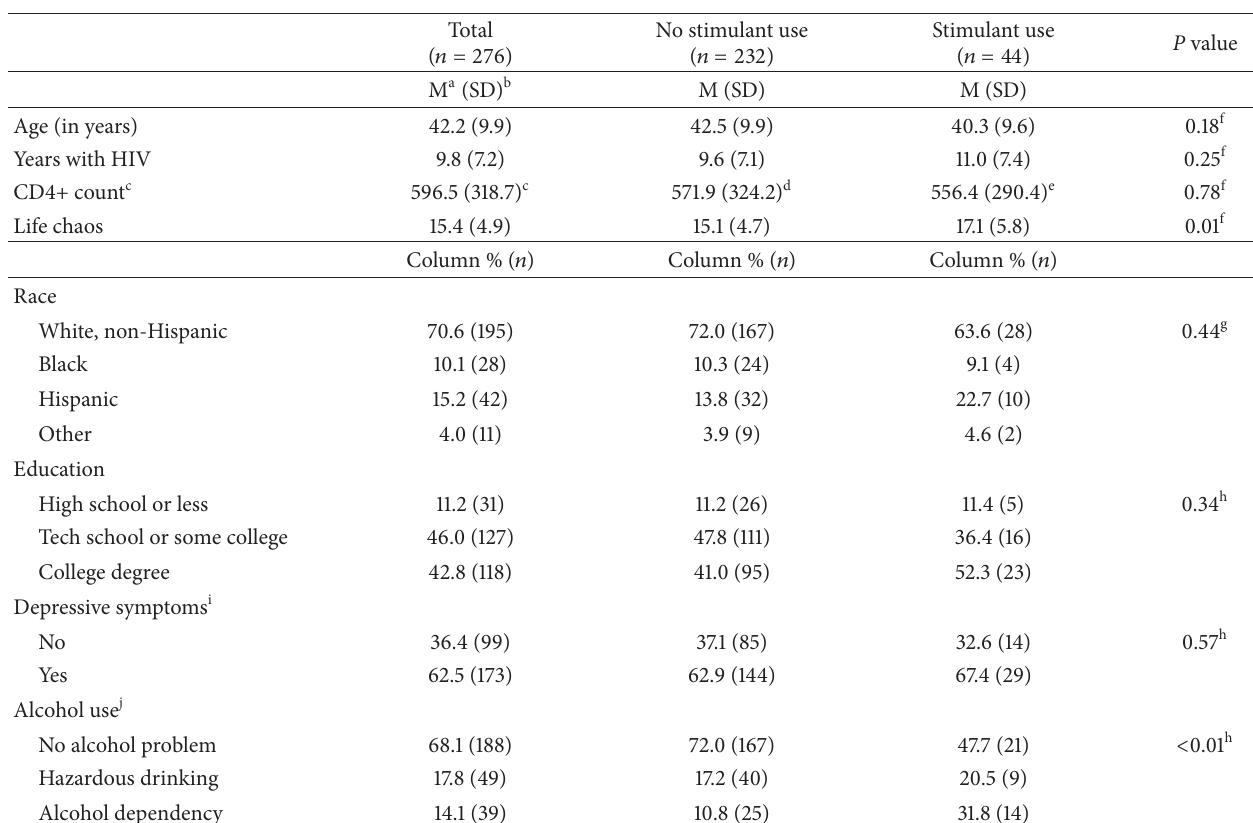
Table 1: Sociodemographic and psychosocial